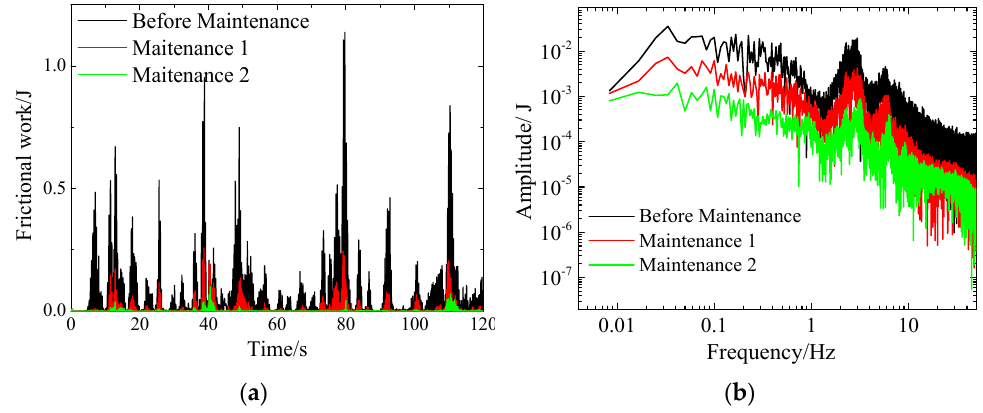
Figure 16. The effect of the maintenance suggestions (frictional work). ( a ) In time domain; ( b ) In frequency domain.